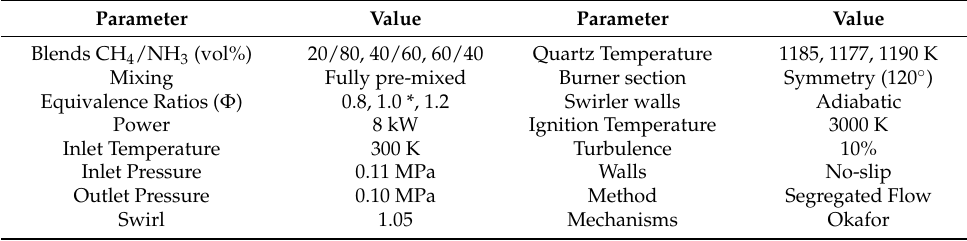
Figure 1. Tangential combustor with measuring techniques and control systems. Table 1. Experimental and numerical (*) boundary